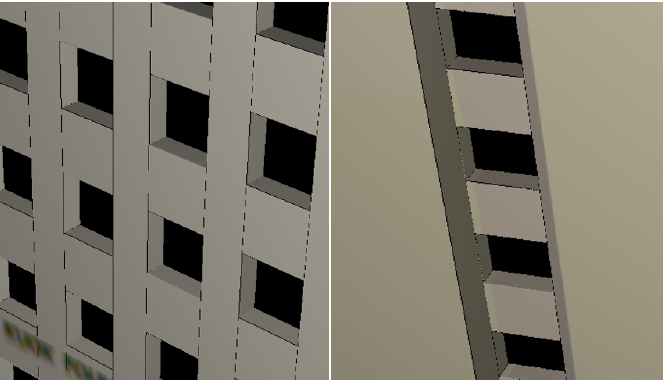
Figure 14. Openings generated by template application. This editing operation will split the boundary surface and generate several new faces co-planar with the boundary